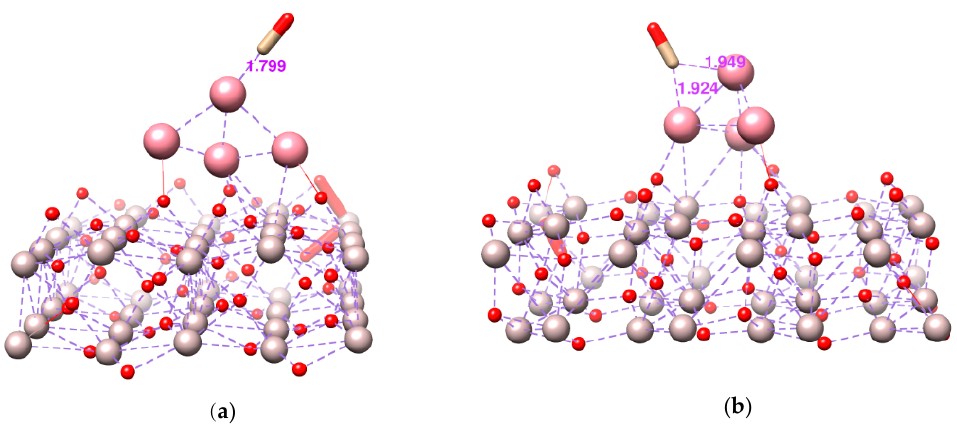
Figure 3. The optimized structure of the d-1 ( a ) and d-2 ( b ) configurations of CO-Co 4 /Al 2 O 3 ; (colors: red—oxygen atom, grey—alumina atoms, violet—cobalt atoms); key distances are given in Å. Table 2. E ads (in kJ mol − 1 ), d C-O (in Å) and bond-dissociation energy (BDE) of C–O (in kJ mol − 1 ). Structures d-1 configuration